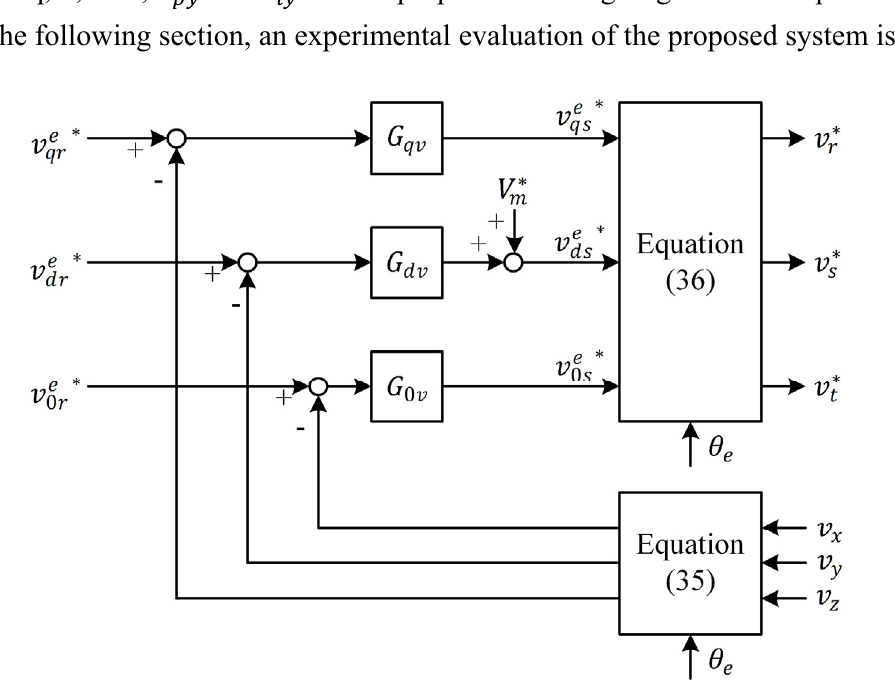
Figure 12. Control block diagram of the voltage